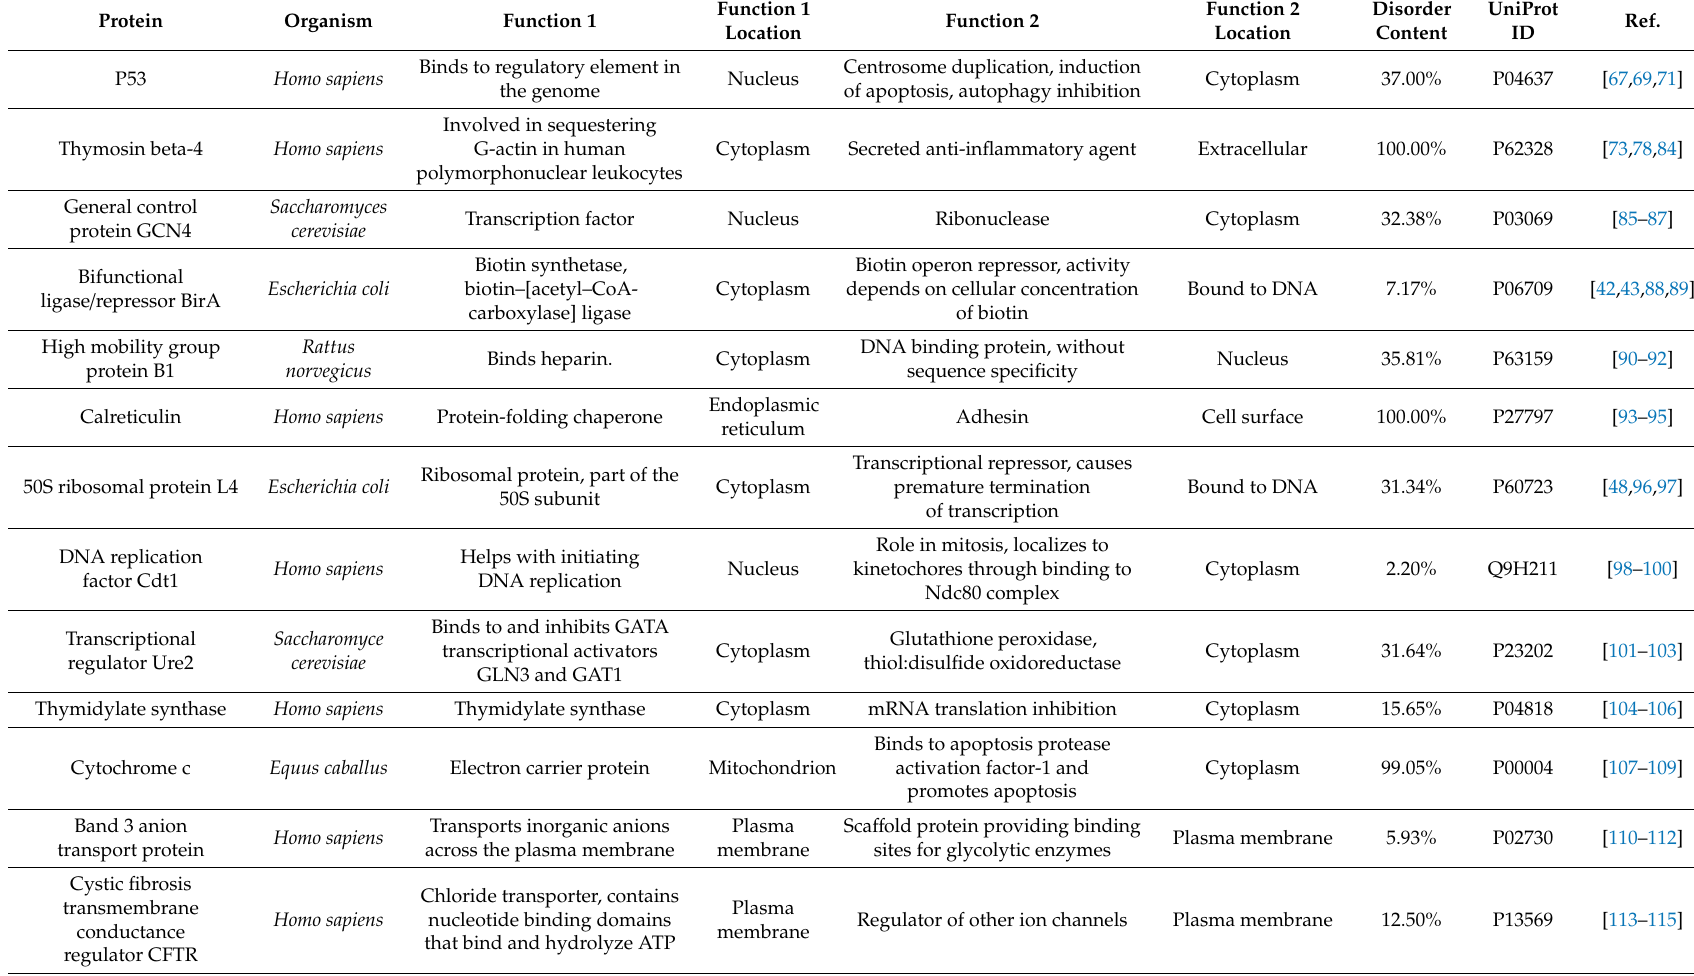
Table 1. Examples of moonlighting proteins that contain intrinsically disordered